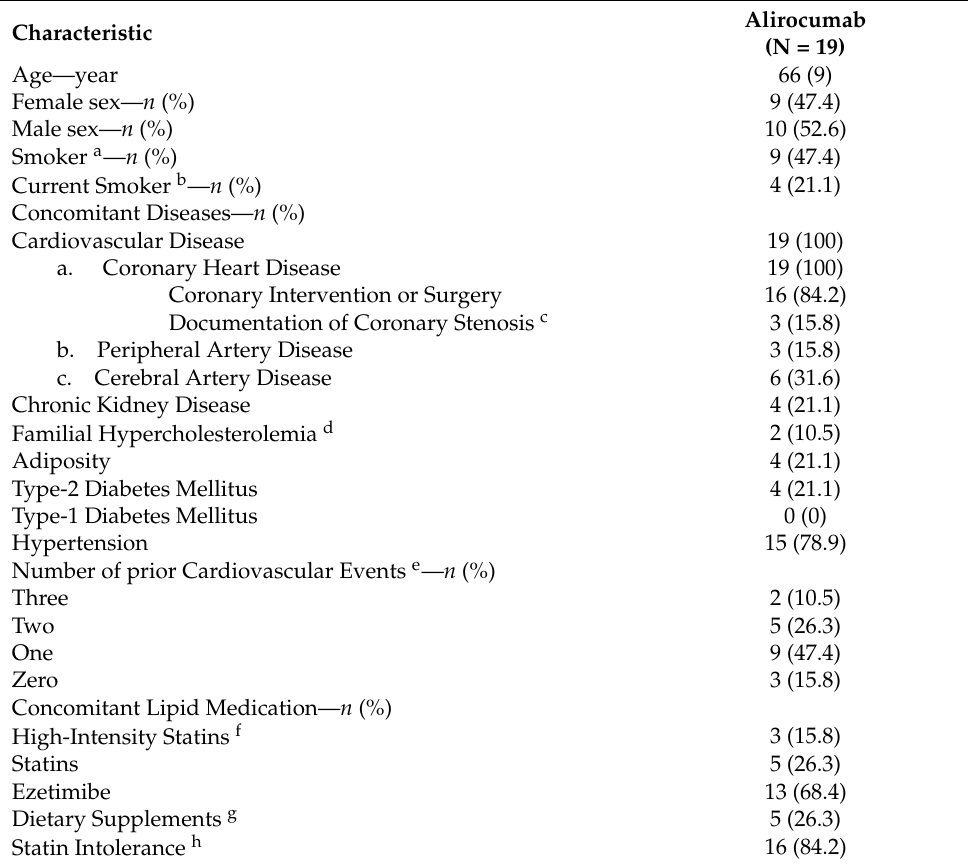
Table 1. Characteristics of trial participants (trial